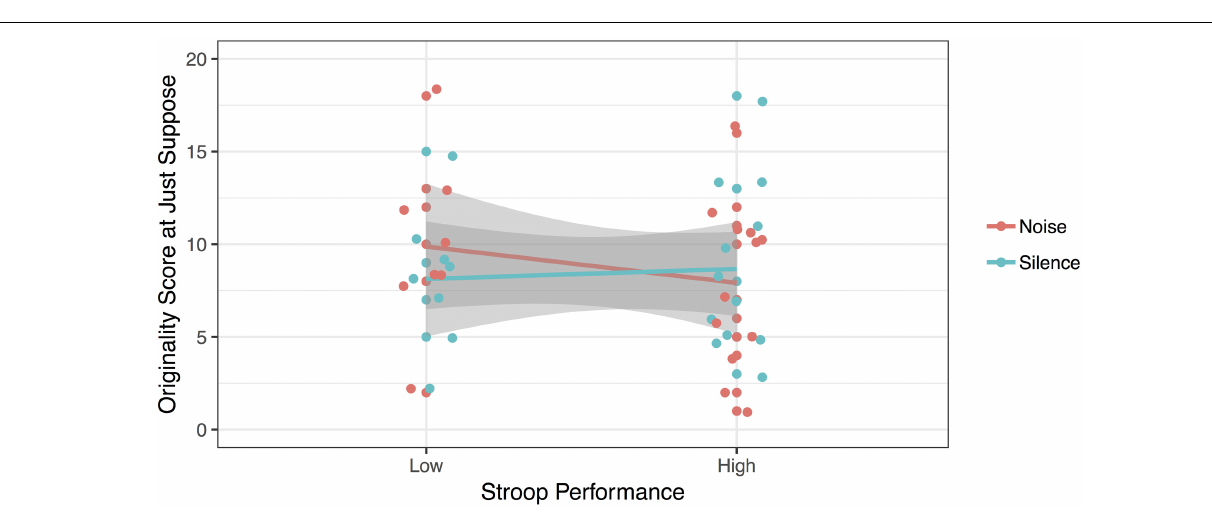
FIGURE 3 | Originality of answers at the Just Suppose task, as a function of Stroop performance, for the older